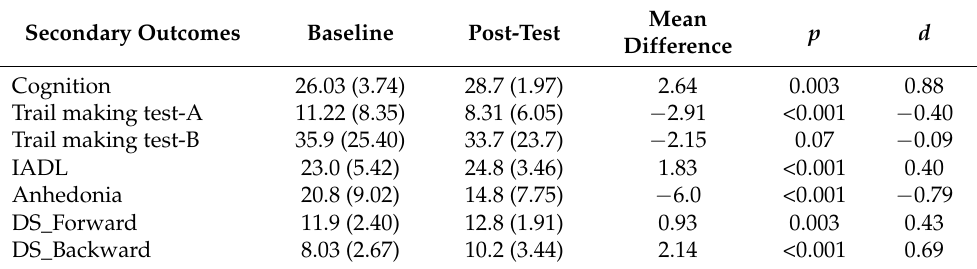
Table 3. The differences in the secondary outcomes between pre- and post-test (n = 30).